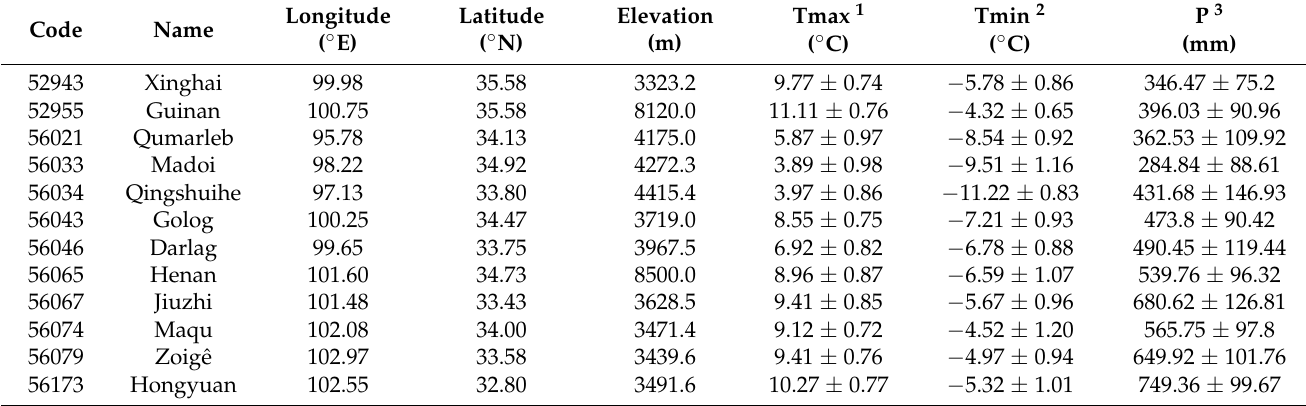
Table 1. Geographical characteristics and meteorological data of 12 sites in SRYRB during the hydrological year of 1960/1961 to